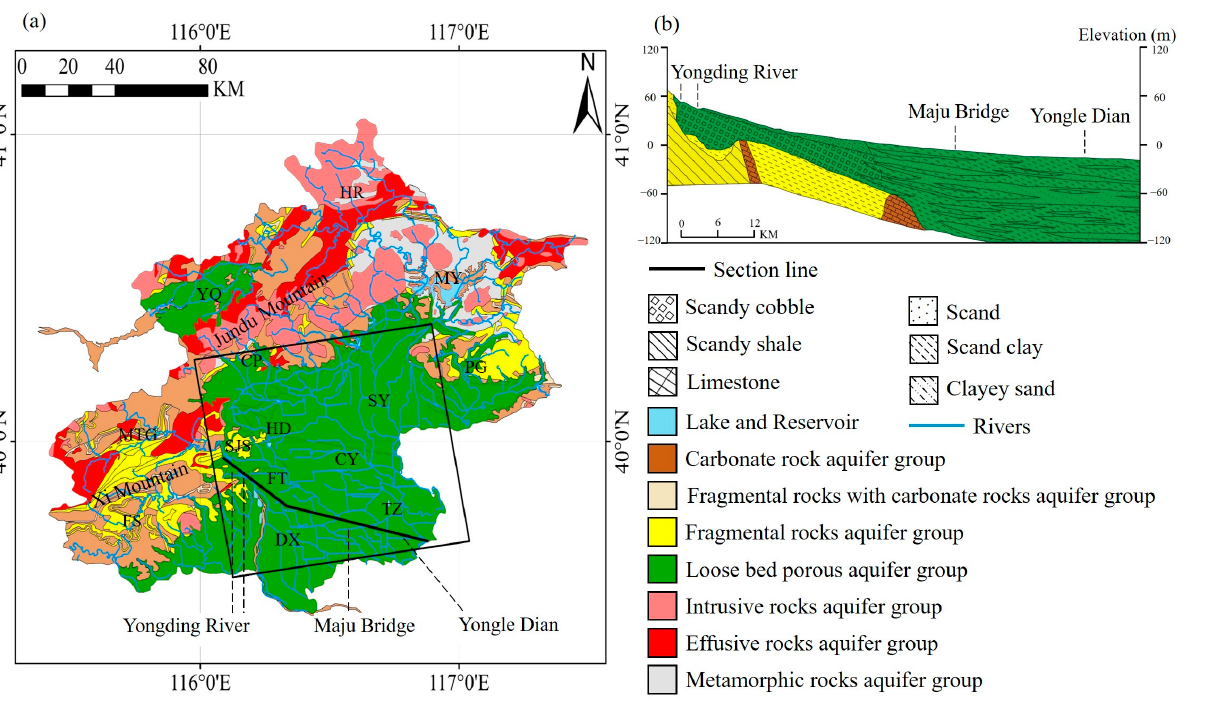
Figure 12. ( a ) Planar distribution of geological formations in Beijing. The black box is the study area in this work, and the black folded lines in the black box are the cross-sectional lines. ( b ) Cross-sectional view of geological formations in Beijing.